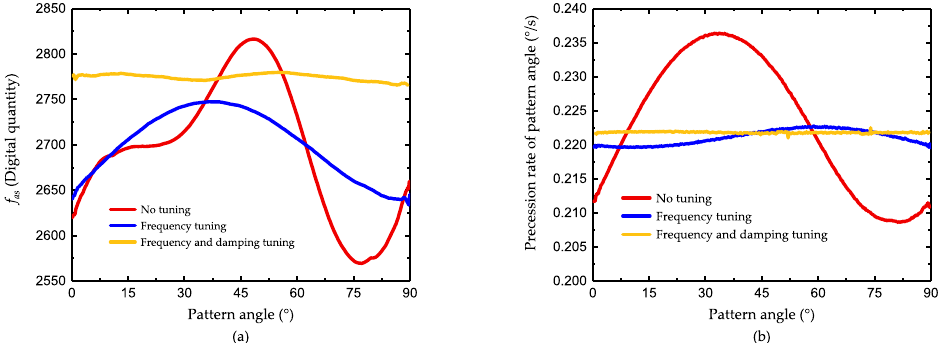
Figure 11. the improvement of gyroscope after tuning ( a ) the improvement in damping asymmetry and ( b ) the improvement in rate measurement.